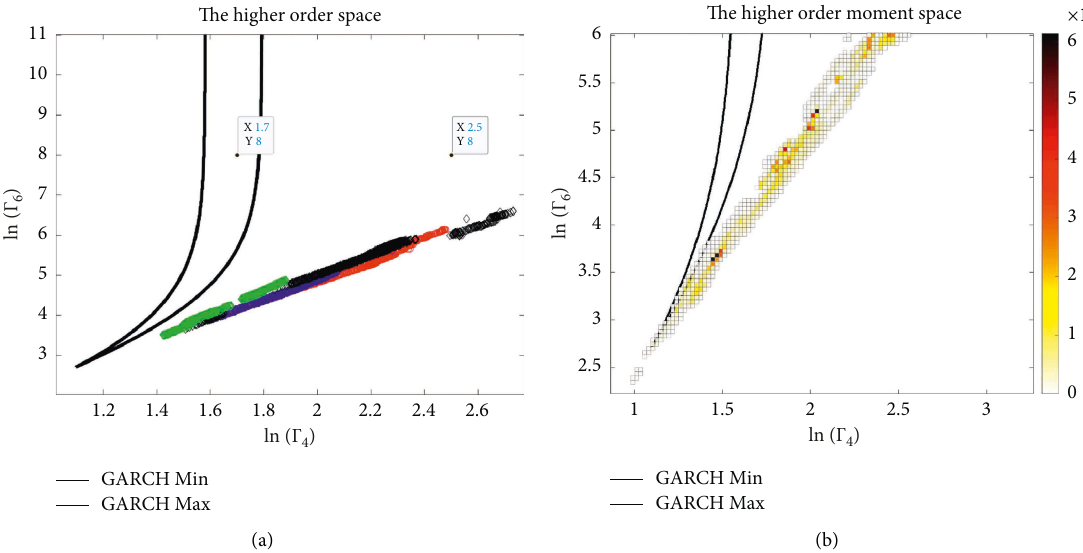
Figure 4: In (a), the phase diagram for (ln ( Γ ) , ln ( Γ ) ) space. The enclosed area between the black lines shows the region in which the 4 6 GARCH-normal model is able to fit the fourth- and sixth-order standardised moment, whilst the rest of the space is where the values of Γ and Γ cannot be fitted by a GARCH-normal (1,1) model. The two highlighted points ( 1 . 7 , 8 ) and ( 2 . 5 , 8 ) show the examples of values of Γ 6 and Γ that can be fitted by a GARCH-normal model and those that cannot, respectively. The other data points in the space represent the 6 empirical data for several companies, truncated to 1% of its overall length, incrementing in percents up to its full length. In (b), we show the histogram for point density on the higher order moment phase space, we detail the specifics of this calculation in A. We consider all possible windows with duration longer than 30 days. We show the histogram alongside the “GARCHable” region. The empirical data is shown for Lloyds Bank, GSK, Barclays Bank, Gold ETFs, S&P 500, DowJones, Rio Tinto, Bank of America, Oil, Natural Gas, Vale, Pfizer, and Citi Bank. This histogram shows the scattering of empirical data in a much clearer way than any error bar estimation, in which some information about the point distribution is lost.